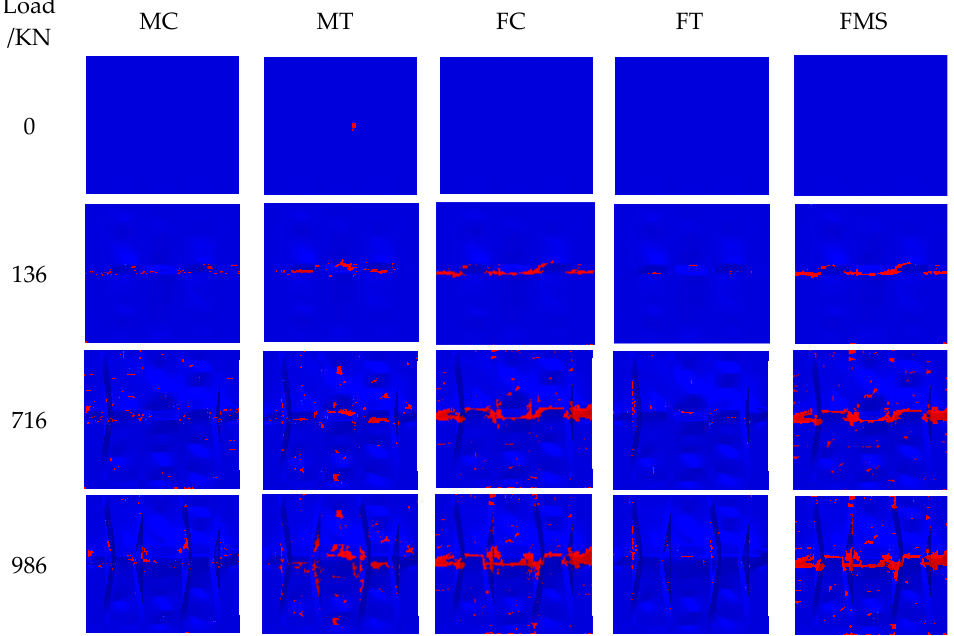
Figure 12. Damage generation and expansion of Panel C1. According to Figure 12, the initial damage is matrix tensile and occurs at the impact area, which is caused by low-velocity impact. Then, fiber compression, matrix compres- sion, and fiber-matrix shear failure occur. When the load is 716 kN, the area of matrix compression, fiber compression, and fiber-matrix shear failure is significantly enlarged. When the load is 986 kN, the stiffened panel is completely destroyed, and the failure mode of CAI is mainly fiber compression, matrix tensile, and fiber-matrix shear failure. CAI damage simulation shows that damage begins at the impact position, then expands from the middle to both sides perpendicular to the loading direction, and finally forms a rela-